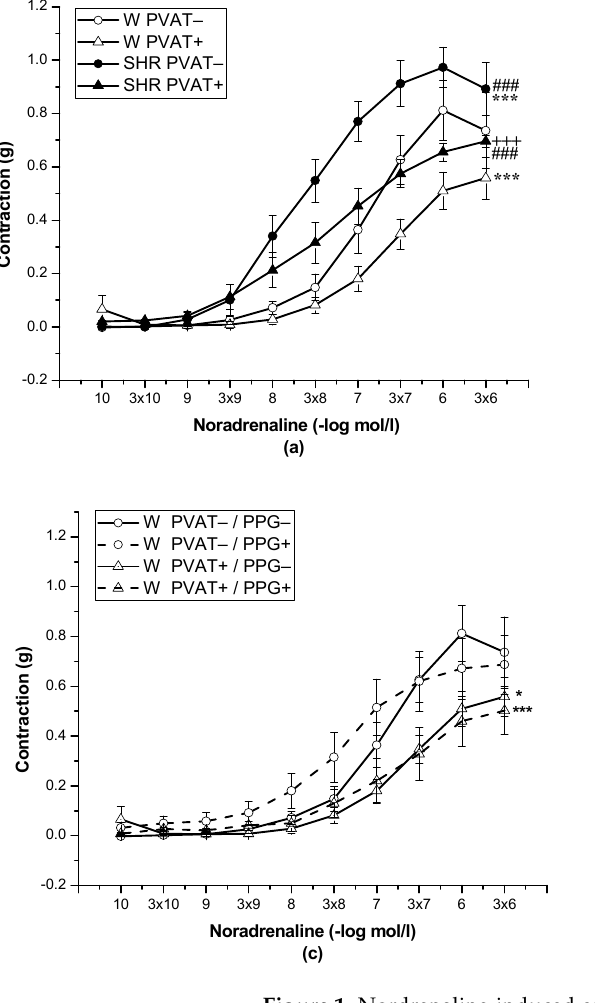
Figure 1. Nordrenaline-induced contractile response of the thoracic aorta in normotensive Wistar rats (W, n = 8) and spontaneously hypertensive rats (SHRs, n = 8) with preserved (PVAT+) or denuded (PVAT − ) perivascular adipose tissue expressed as the active wall tension ( a ), and as percentages of the maximal-reached response induced by noradrenaline ( b ), before (PPG − ) and after (PPG+) pretreatment with DL-propargylglycine ( c , d ). The results are presented as the mean ± S.E.M., and differences between groups were analyzed by three-way ANOVA with the Bonferroni post hoc test on ranks. *** p < 0.001 vs. W PVAT − ; +++ p < 0.001 vs. SHR PVAT − ; ### p <0.001 vs. W PVAT+; * p < 0.05 vs. W PVAT − ; * p < 0.05 vs. W PVAT − /PPG − ; *** p < 0.001 vs. W PVAT − /PPG − ; +++ p < 0.001 vs. SHR PVAT − /PPG − ; ## p < 0.01 vs. SHR PVAT+/PPG − . Table 2. Sensitivity of the thoracic aorta of Wistar and spontaneously hypertensive rats to noradren- The application of cumulative concentrations of the H 2 S donor Na 2 S · 9H 2 O (20, 40, aline. 80, 100, 200, and 400 µ mol/L) to NA-precontracted TA rings induced a biphasic effect in Wistar Rats Spontaneously Hypertensive Rats both Wistar rats and SHRs. Lower concentrations of Na 2 S induced contraction (20, 40, and PVAT − PVAT+ PVAT − PVAT+ 80 µ mol/L), whereas higher concentrations (100, 200, and 400 µ mol) evoked vasorelaxation PPG − PPG+ PPG − PPG+ PPG − PPG+ PPG − PPG+ of the arterial wall (Figure EC 50 , the negative logarithm of NA molar concentration inducing the half-maximum response; NA, noradrenaline; PPG, DL-propargylglycine. Values are mean ± S.E.M. * p < 0.05 vs. Wistar PVAT − PPG − ; ** p < 0.01 vs. Wistar PVAT − PPG − .